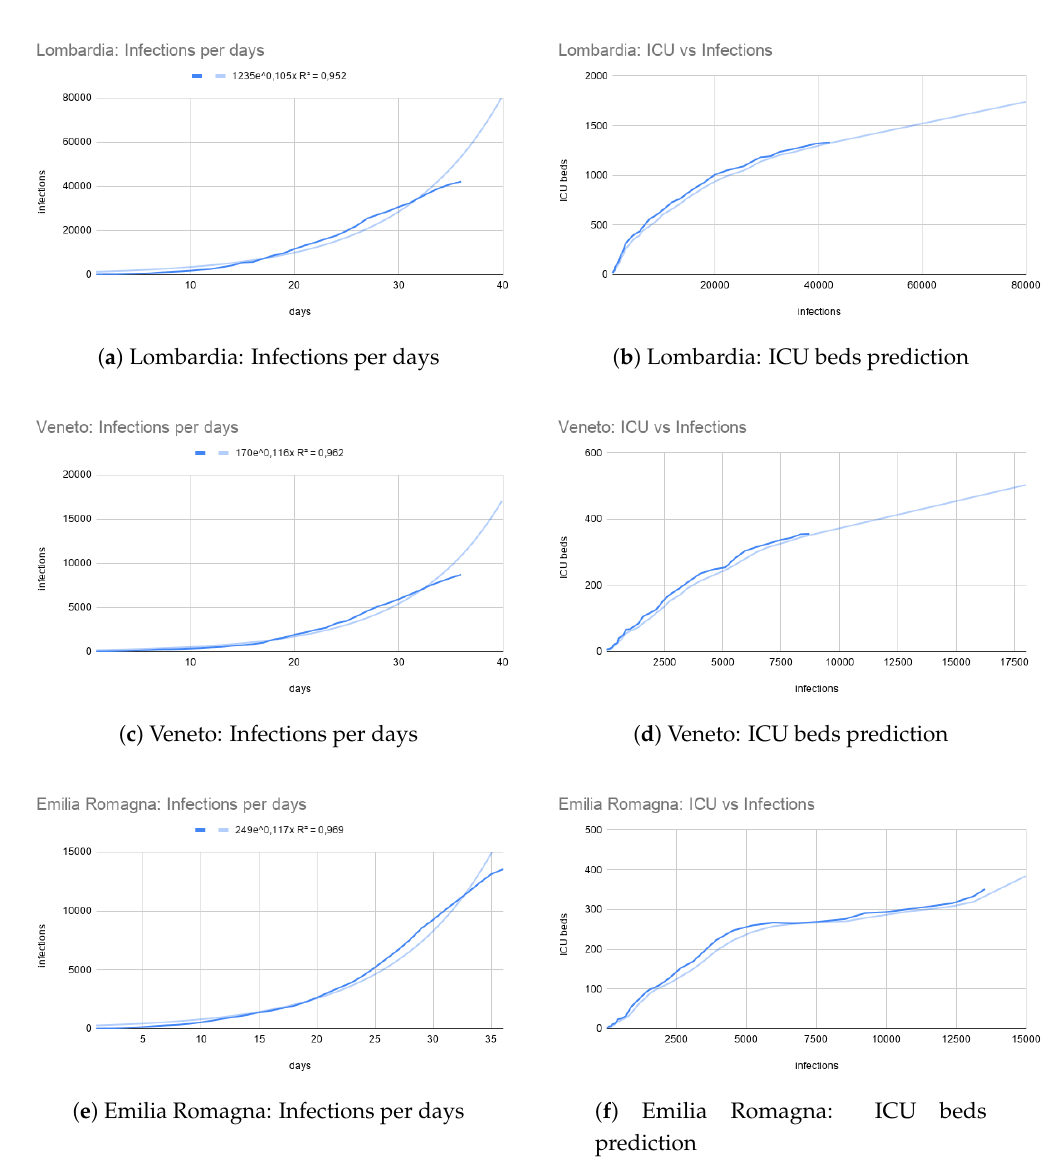
Figure 5. Infections per days (with exponential fitting) and ICU bed vs. Infection (with moving average of modulus 3) graphs for the Lombardia, Veneto and Emilia Romagna northern regions at the date of 30